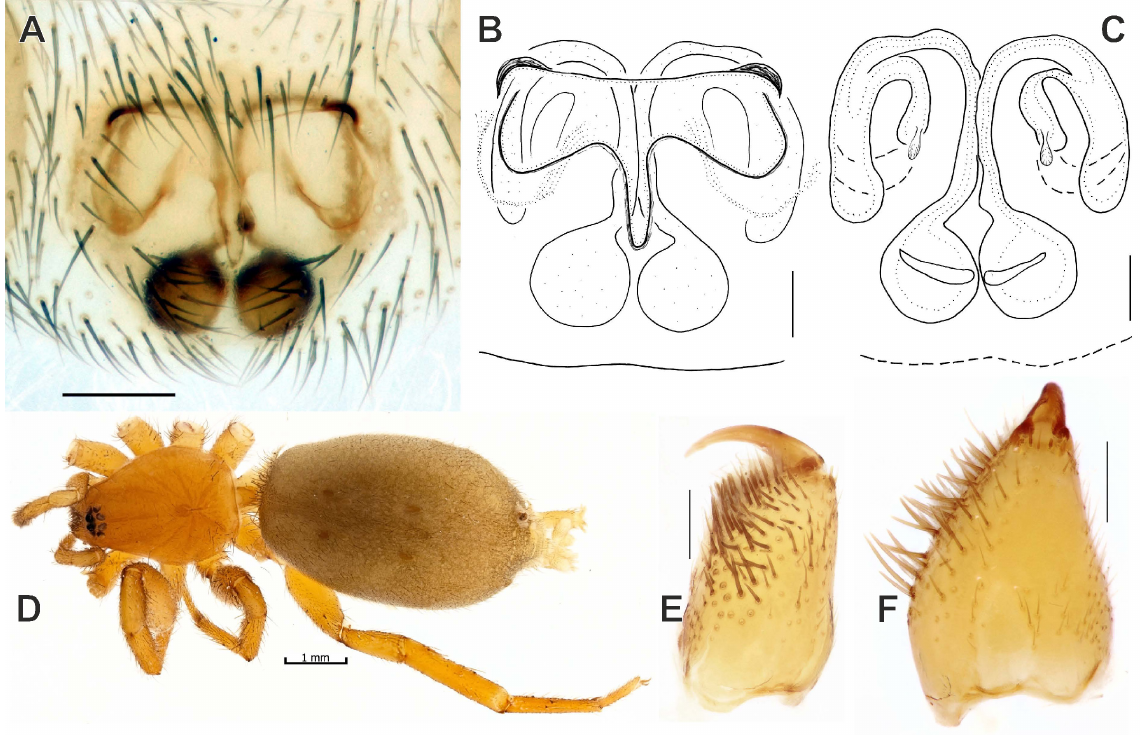
Fig. 15. Marinarozelotes achaemenes sp. nov., holotype, ♀ (MHNG). A–C . Epigyne, ventral and dorsal views. D . Habitus, dorsal view. E–F . Chelicera, posterior and anterior views. Scale bars: A, E–F = 0.2 mm; B–C = 0.1 mm; D = 1